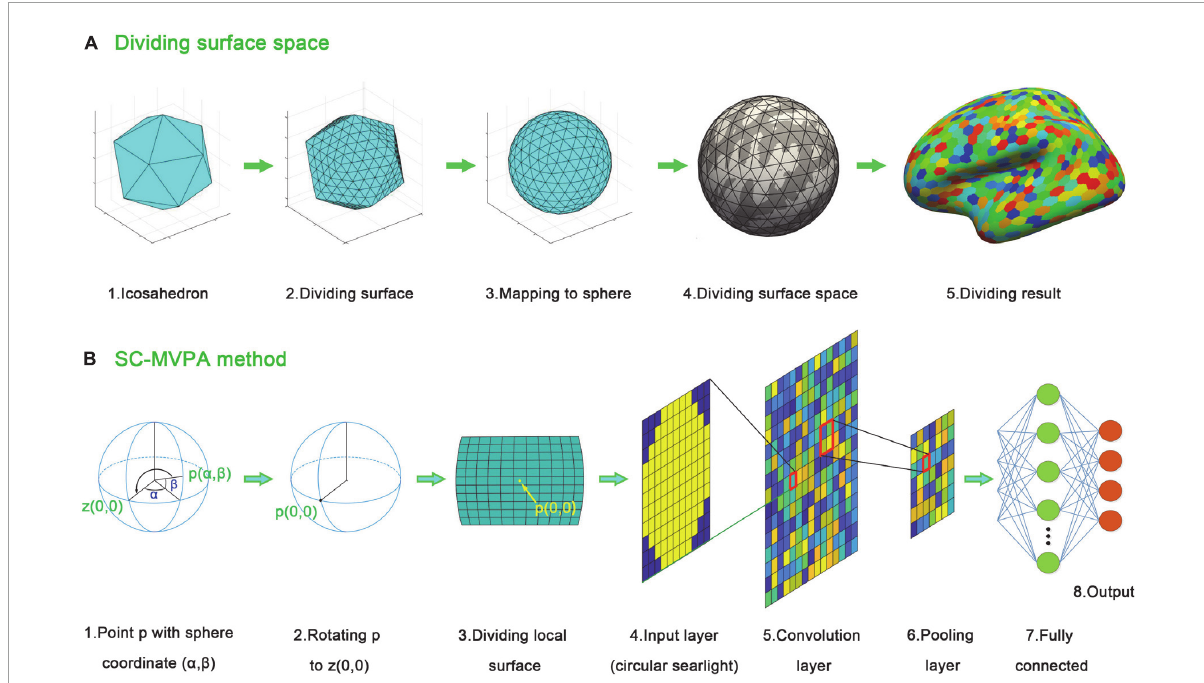
FIGURE2 Analyzing stream of SC-MVPA. (A) Dividing algorithm used to divide the template surface space. (B) Analyzing stream of SC-MVPA. For any point p ( α , β ) in the downsampled sphere space of fsaverage, the sphere is rotated to rotate p to z (0,0). After that an 11 × 11 grid around p (0,0) is acquired. The BOLD signal in cells are averaged, forming an 11 × 11 searchlight. A circle (with a radius of 11/2) is applied to the 11 × 11 grid, forming a circular searchlight. The circular searchlight then entered into the